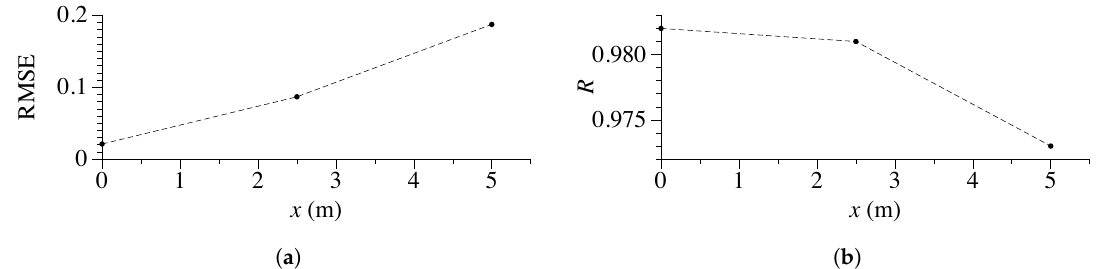
Figure 16. Comparison of accuracy between the numerical and experimental wave signal at different wave gauge positions by ( a ) RMSE for wave phases; ( b ) R .